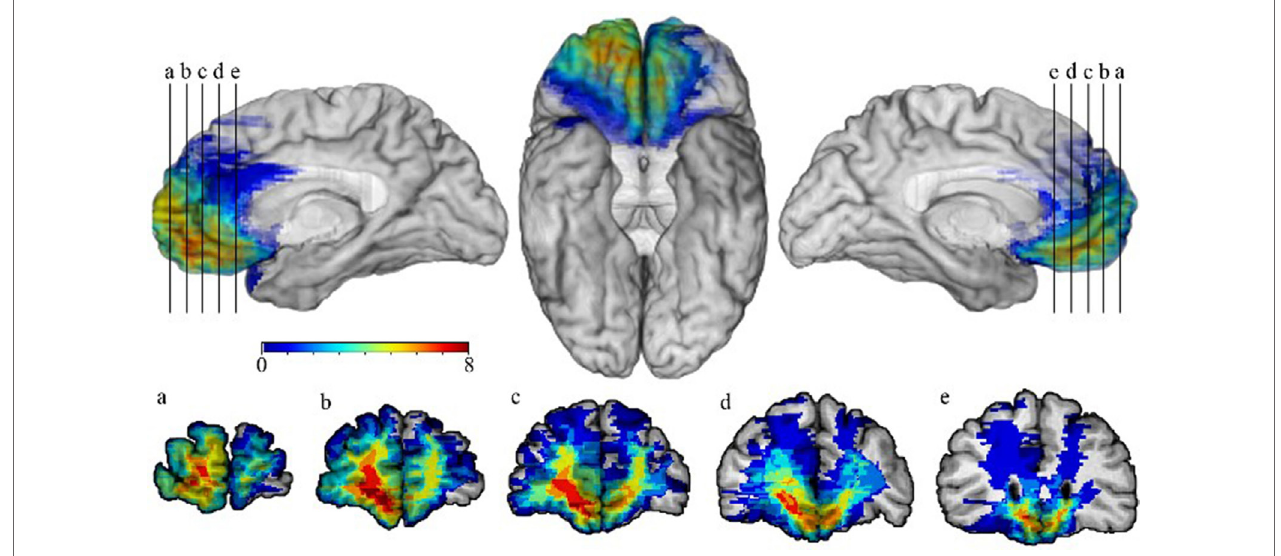
FigUre 1 | Lesion overlap map of patients with damage to the ventromedial prefrontal cortex (vmPFC). The lesion overlap map of eight patients with damage to the vmPFC is shown. Images are presented using radiological convention. Warmer colors indicate greater numbers of patients whose lesions overlap in a particular region, whereas cooler colors indicate fewer lesion overlaps. Overlap was greatest bilaterally in the ventromedial prefrontal region, with the cortex and white matter in the right vmPFC being involved in all eight patients.